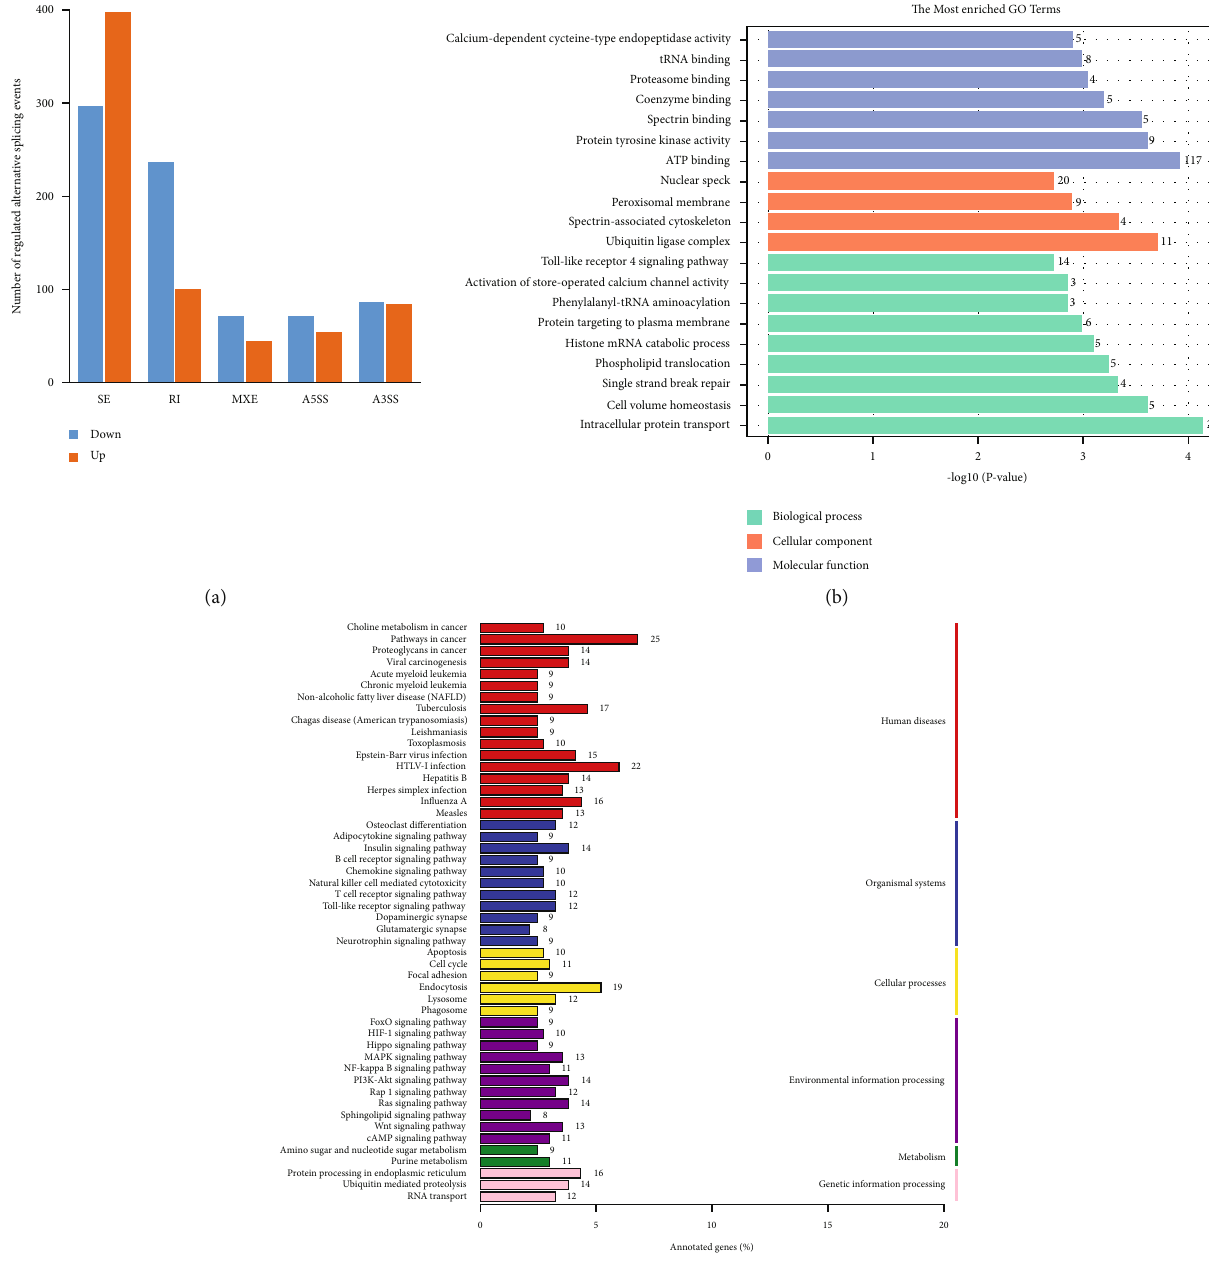
Figure 4: Enrichment biological function of regulated alternative splicing events in PBMCs between DCC and LC. (a) The number of signi fi cant regulated alternative splicing events, including events of skipped exon (SE), retained intron (RI), mutually exclusive exons (MXE), 5 ′ splice site (A5SS), and 3 ′ splice site (A3SS) events. (b) GO functional enrichment of di ff erent RASEs. (c) KEGG pathway enrichment analysis